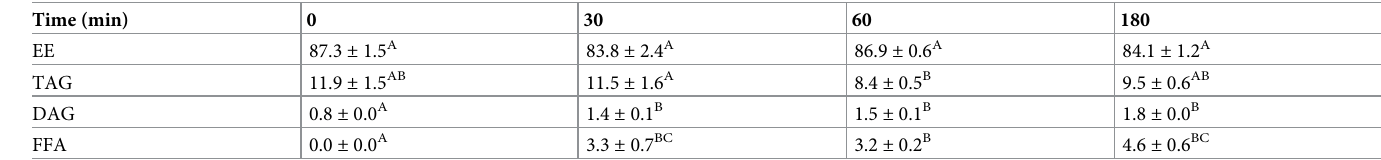
Table 5. Lipid class composition (weight percent) of the ethyl ester concentrate (time 0) and changes during in vitro digestion (n = 3).